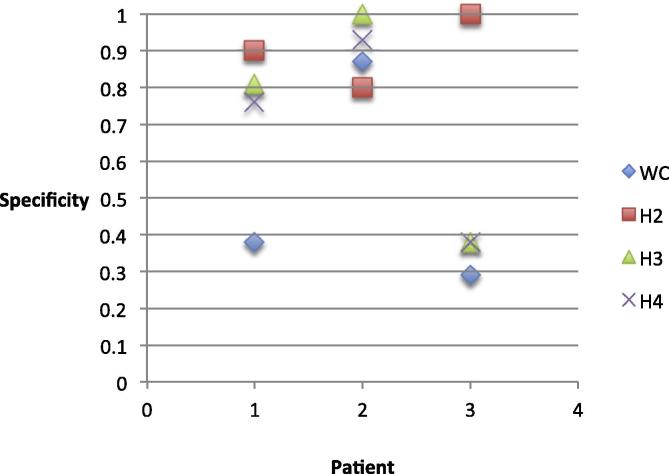
Specificity of IED marking of WC and H2, H3 and H4 for patient 1, 2 and 4.